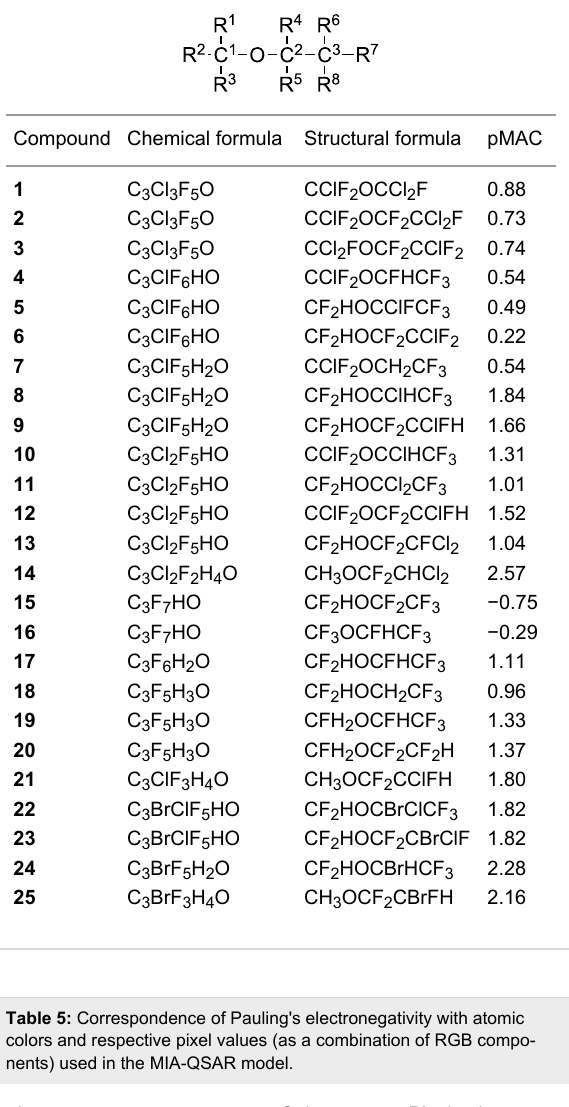
Compound Chemical formula Structural formula